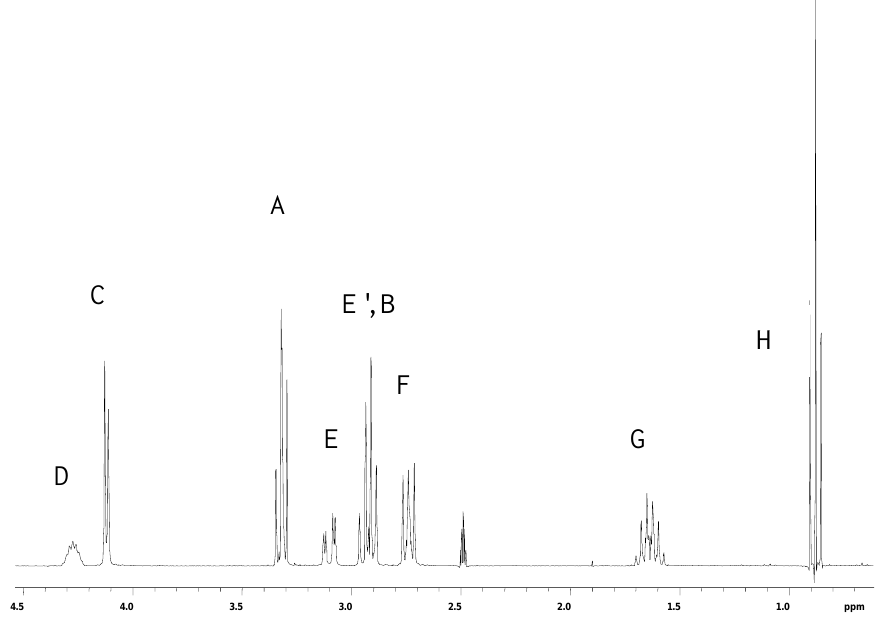
Figure 1 . Aliphatic Part of the 1 H-NMR Spectrum of 1(cid:127)HCl (in DMSO- d